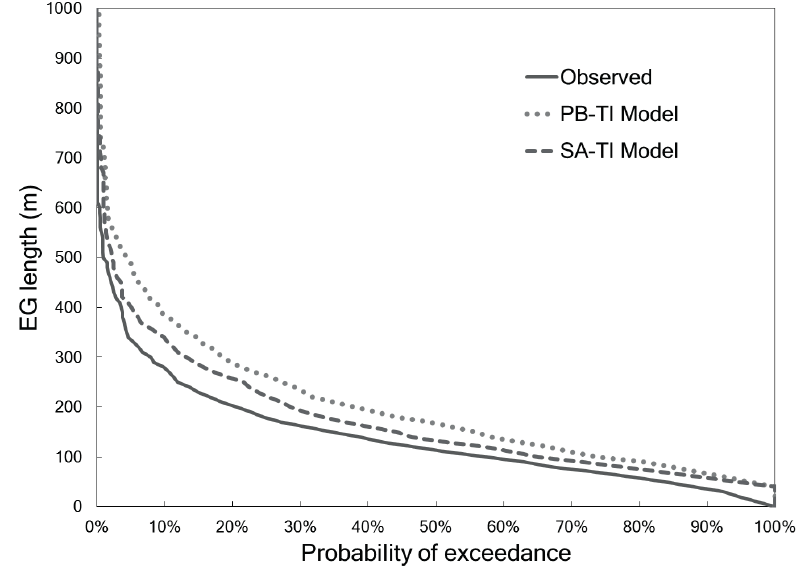
Fig. 3 Probability of exceedence for lengths of observed EGs, PB-TI and SA-TI